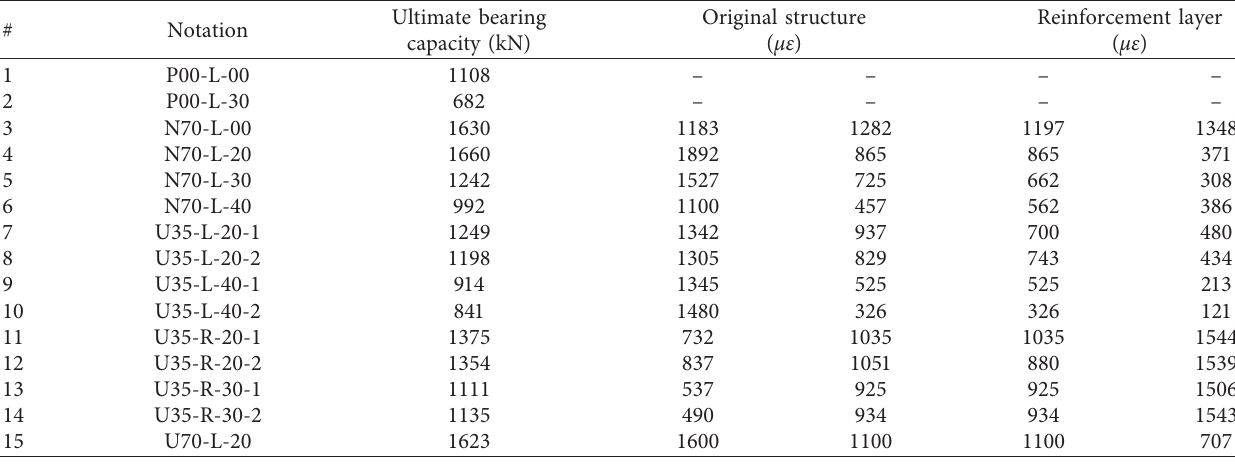
Table 6: Measured values of bearing capacity and strain at